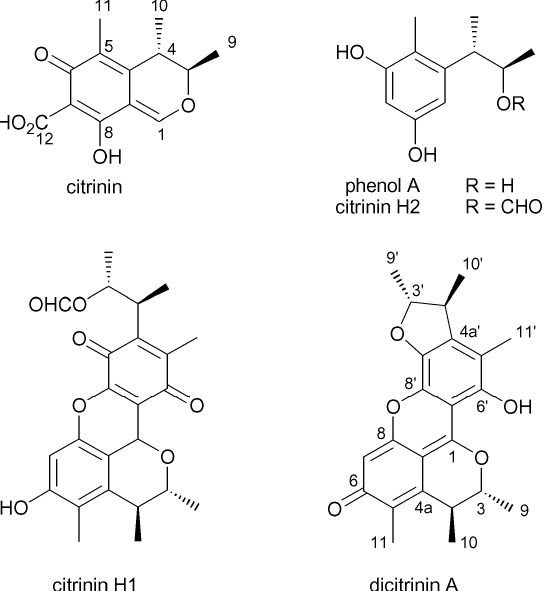
Figure 1. Chemical structures of citrinin and its decomposition products citrinin H1, citrinin H2, dicitrinin A and phenol A (based on Clark et al. [31]).